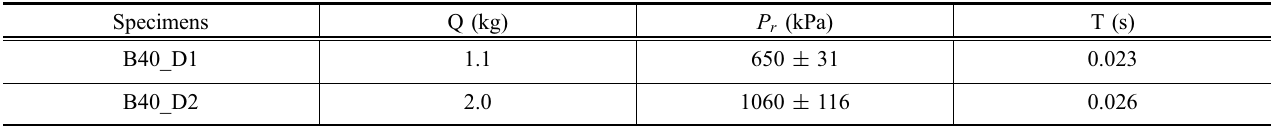
Table 3 The details of blast